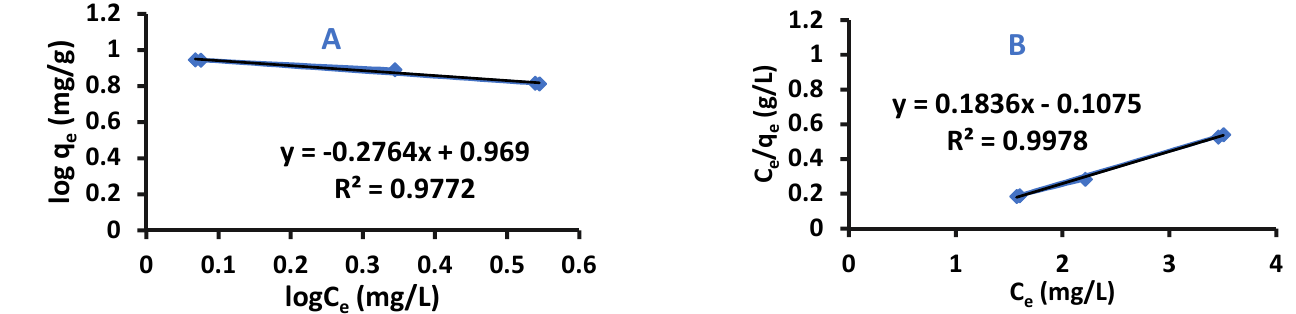
Figure 10. ( A ) Freundlich ( B ) Langmuir plots for difenoconazole by Cell-X (pH: 6, volume: 10 mL, temperature: 20 °C, adsorption time: 20 min, dosage: 10 mg).